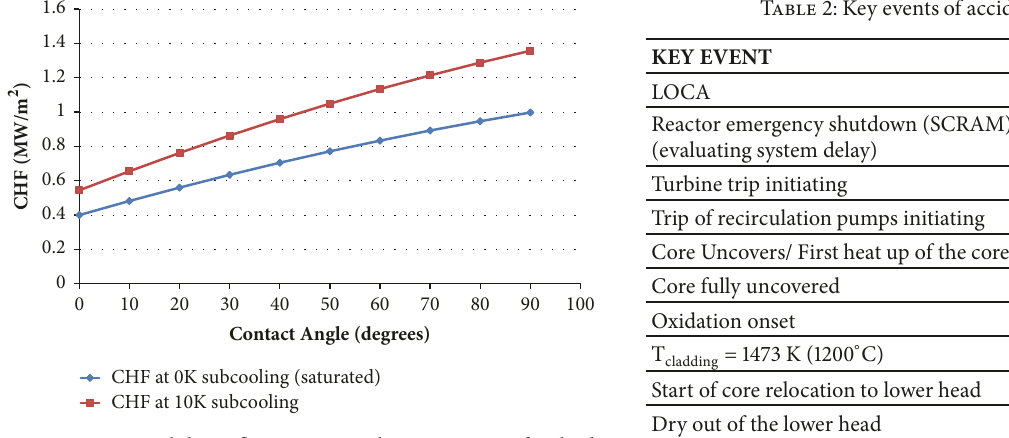
Figure 3: Critical heat flux at atmospheric pressure for both subcooling options in COUPLE heat transfer correlation.